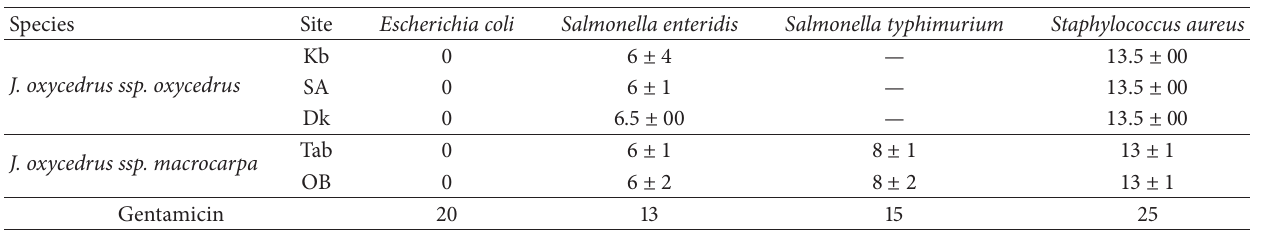
Table 3: Antimicrobial activity of the investigated essential oils in agar diffusion test ∗ (zone diameter are expressed in mm). Species